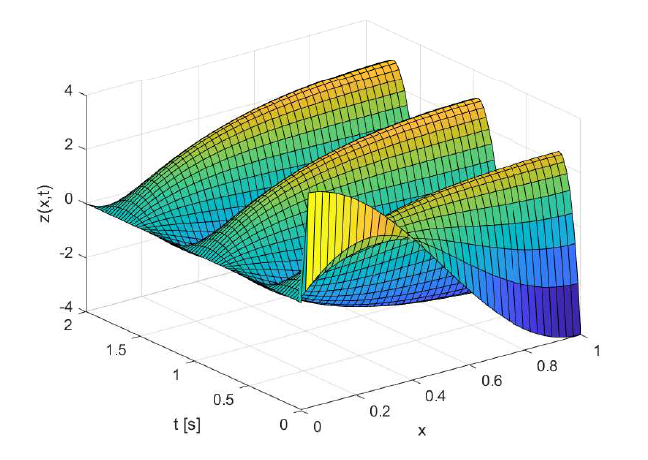
Figure 2. Spatial distribution of the solution surface corresponding to the rejection of constant